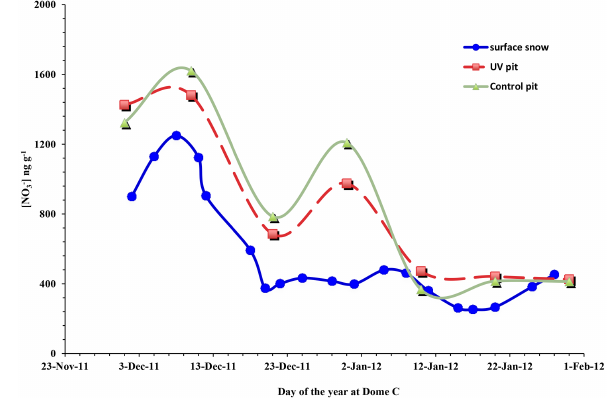
Figure 4. The nitrate concentration profile for the surface snow col- lected in the vicinity of the two pits compared with the UV and control pit surface snow (0–2cm